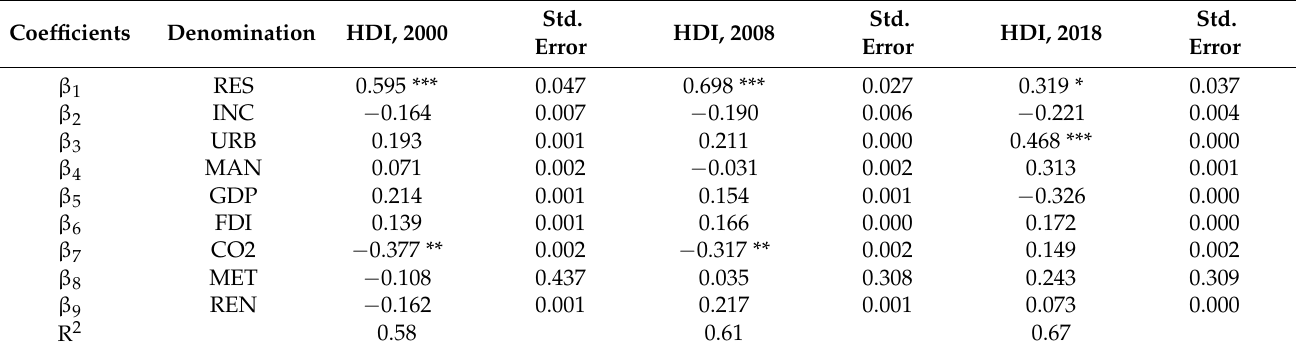
Table 2. Regression results.